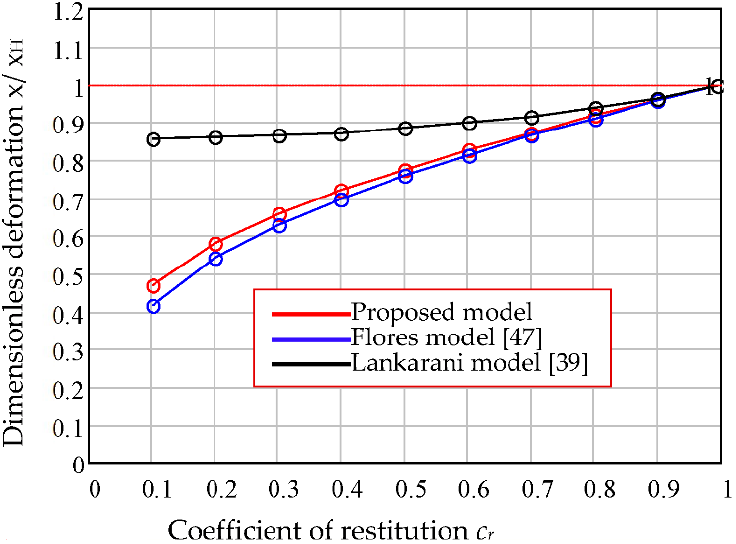
Figure 23. The variation of maximum approach ( 𝑥 (cid:3040) ) versus coefficient of restitution ( 𝑐 (cid:3045) ).